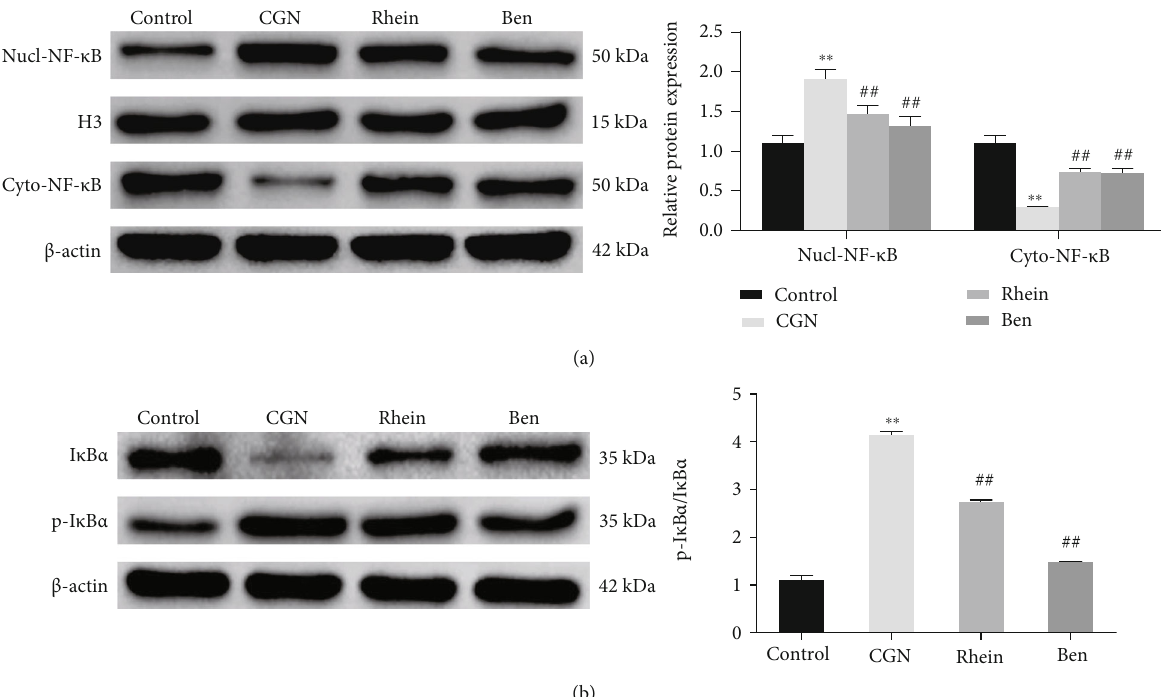
Figure 4: E ff ects of rhein on NF- κ B signaling pathway in rats with chronic glomerulonephritis. (a) Western blot was utilized to determine NF- κ B expression in the nucleus (Nucl-NF- κ B) or cytoplasm (Cyto-NF- κ B) of rat kidney tissues in each group ( n = 6 ). (b) Western blot was applied to detect I κ B α or p-I κ B α expression in the kidney tissues of rats in each group ( n = 6 ). ∗∗ p < 0 : 01 , control group, ## p < 0 : 01 , CGN